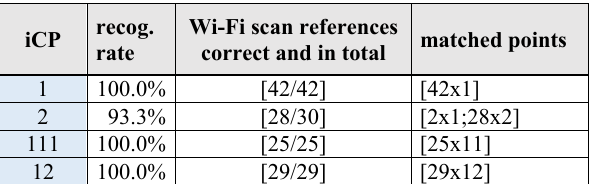
Table 1. Detailed results of the fingerprinting strategies for